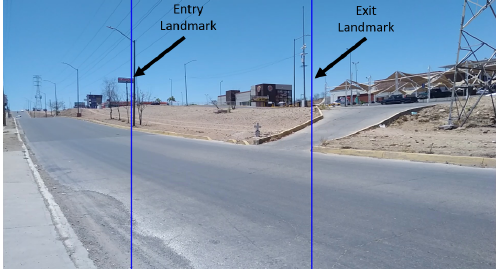
Figure 8. Sample of camera position a x axes landmarks (entry and exit).